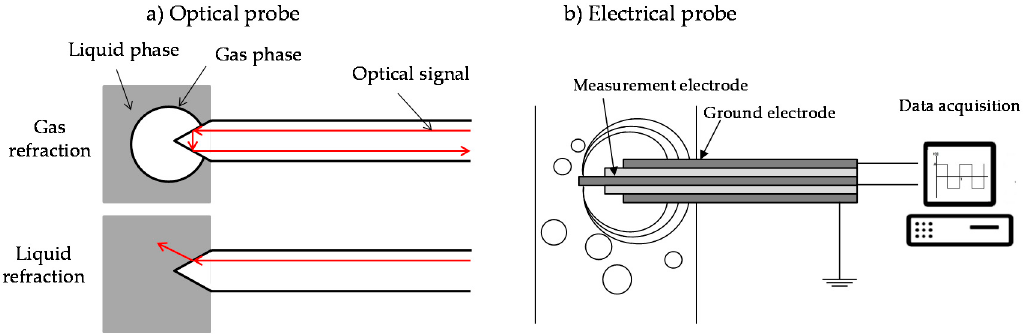
Figure 2. Schematic diagram of ( a ) optical probe and ( b ) electrical probe.